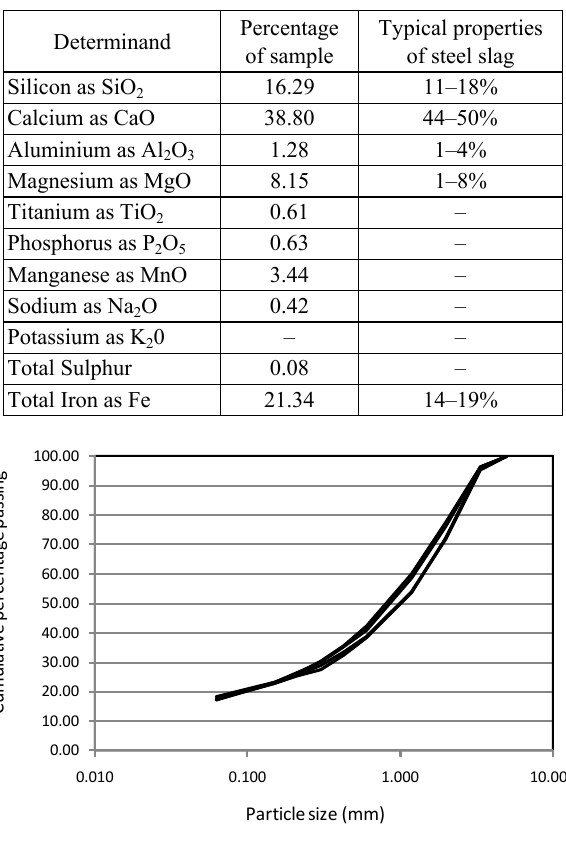
Fig. 1. Particle size distribution of limestone fines from the Sandside